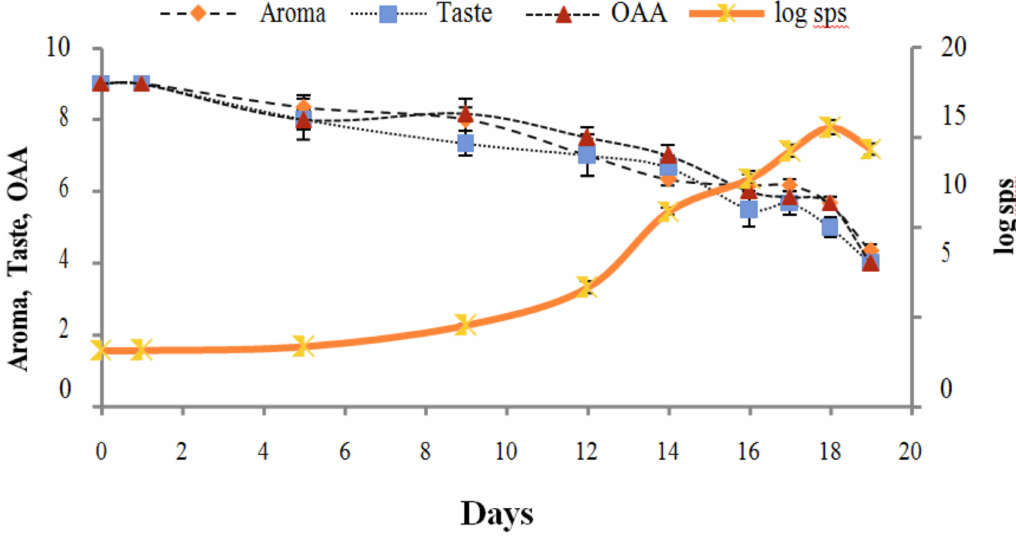
Figure 7. Relationship of standard plate count log cfu/mL growth trends with sensory scores of pasteurized milk for spoilage detection stored at 10 ◦ C.